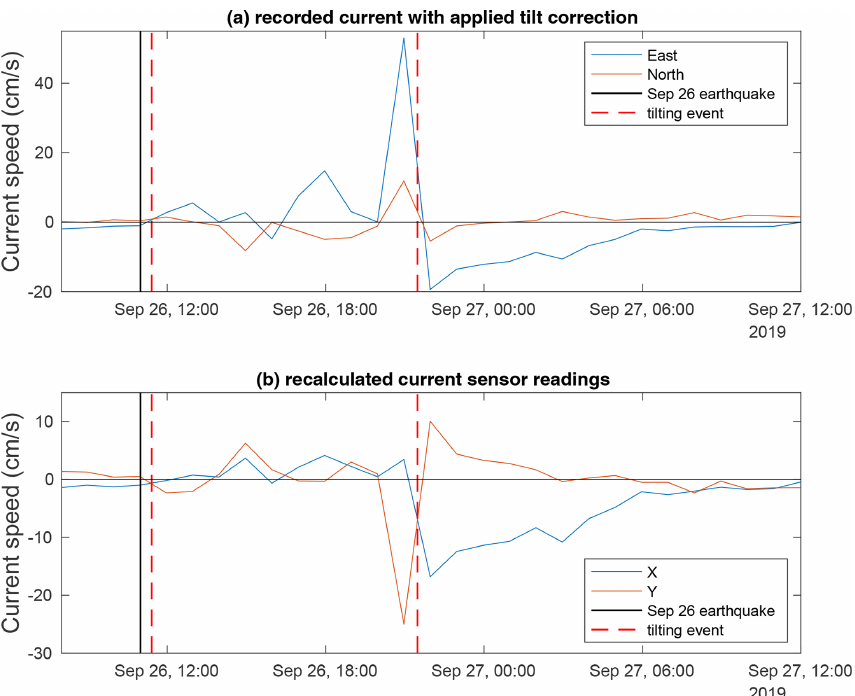
Figure 7. Current record acquired around the time of occurrence of a M w 5.8 earthquake. (a) Instrumental record, automatically corrected for tilt and heading. (b) Recalculated readings in the x and y axis of the Doppler sensor (see text for